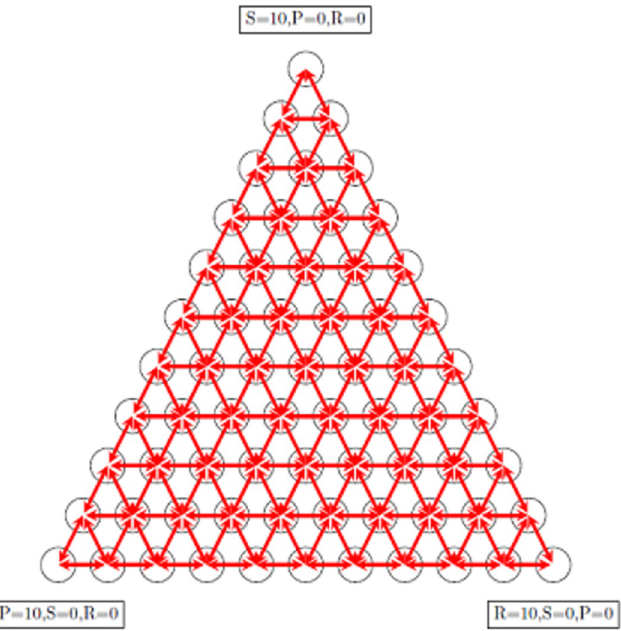
Fig 8. The Markov chain corresponds to an ergodic RSP game for N = 10. The total number of states is 55 and the arrows determine the allowed transition between states. All arrows are two-way which means when the Markov chain is in a state there is a non-zero probability to escape from